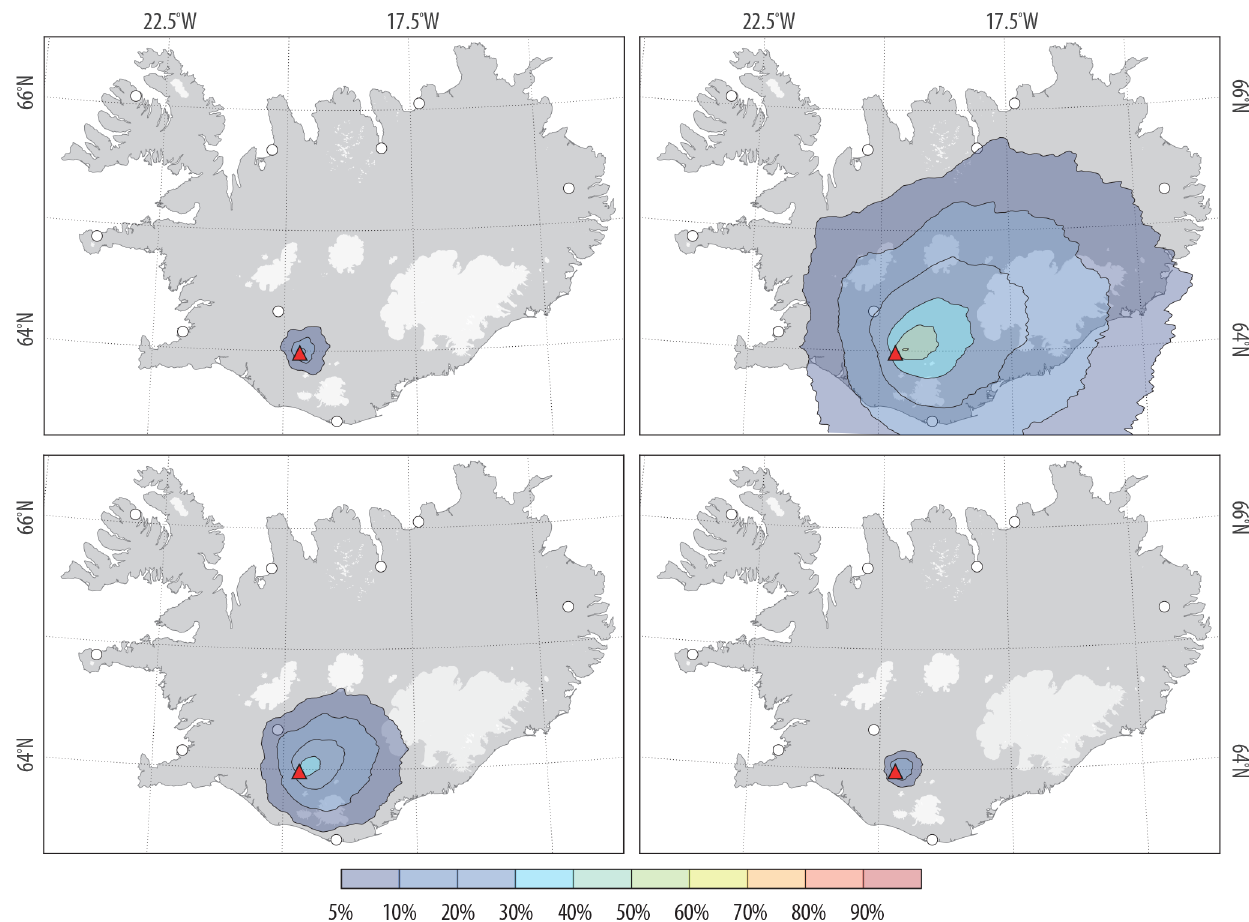
Figure 8. Probability maps (%) for ground accumulation for an eruption at Hekla. (a) ERS for a 2000-type eruption, threshold of 1kgm − 2 ; (b) ERS for a 1947-type eruption, threshold of 1kgm − 2 ; (c) ERS for a 1947-type eruption, threshold of 10kgm − 2 ; (d) ERS for a 1947-type eruption, threshold of 100kgm − 2 . Eruption parameters are summarized in Table 3 and Fig.